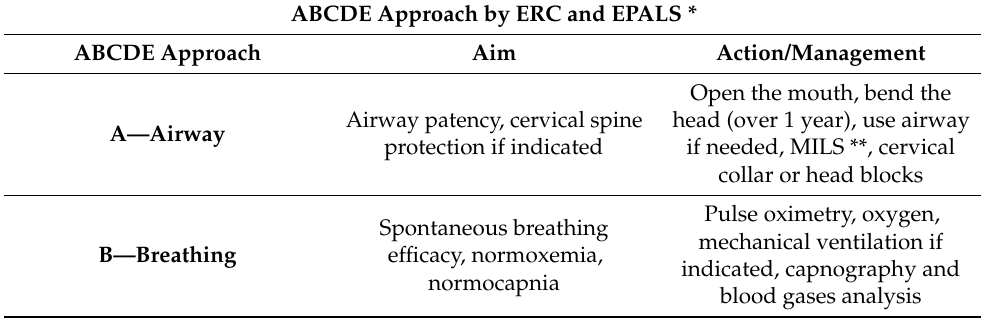
Table 3. Recommended initial approach to a patient at